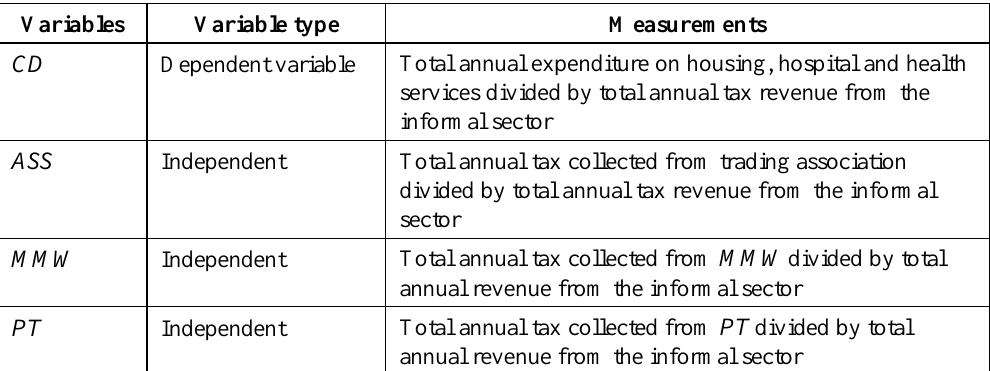
Table 1. Measurement of Variables ( authors’ synthesis of the report from Lagos State Ministry of Finance, Budget and Planning)